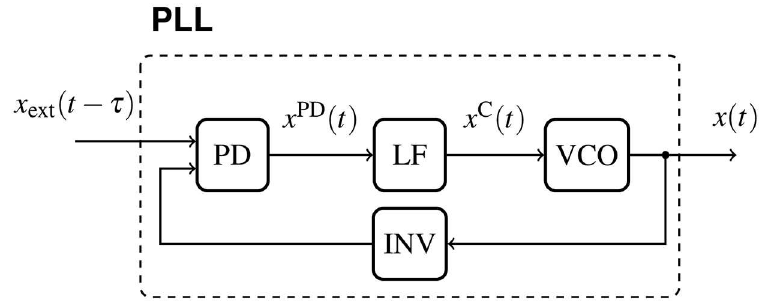
Fig 1. Signal flow model of the PLL considered in this paper. The delayedinput signal to the PLL is denotedby x ext ( t − τ ) and its output signalby x ( t ). The output signal at the phase detector (PD) is denotedby x PD ( t ) and the output signal at the loop filter (LF) by x C ( t ). The output signal x ( t ) is generated by a voltage- controlled oscillator (VCO, square-wave symbol) and fed back to the PD. The feedbackloop may containa signalinverter (INV). © 2015 IEEE. Reprinted, with permission, from IEEE Proceedings: Synchronization of mutually coupleddigital PLLs in massive MIMO systems